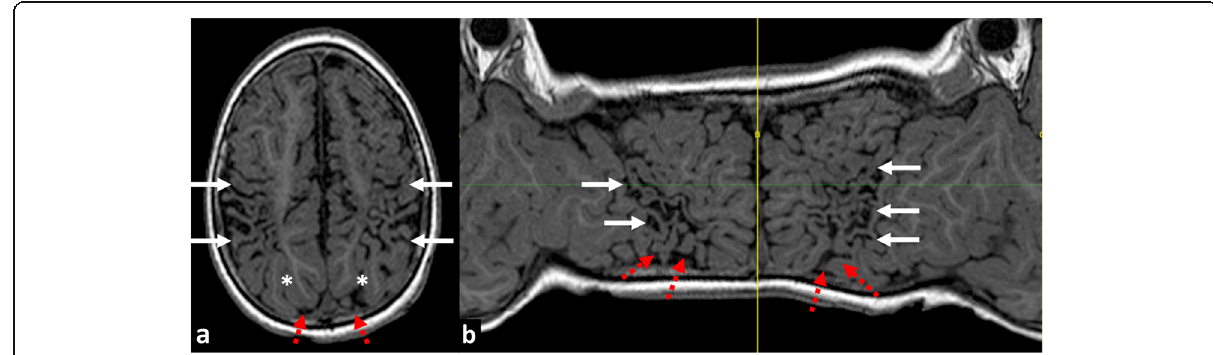
Fig. 8 a Axial reference T1W image and ( b ) flat earth Mercator map derived from curved reconstructions of 3D T1-weighted images in a 6-year- old girl demonstrating atrophy and ulegyria in the peri-Sylvian (white arrows) and posterior watershed (red dashed arrows) distribution in a child who suffered partial-prolonged hypoxic-ischaemic injury perinatally at term gestation. Note sparing of the anterior and parasagittal watershed regions as well as the temporal lobe portions of the peri-Sylvian watershed. Also, note the asterisk depicting the apparent discontinuity on the axial image which is clearly shown to be continuous on the Mercator